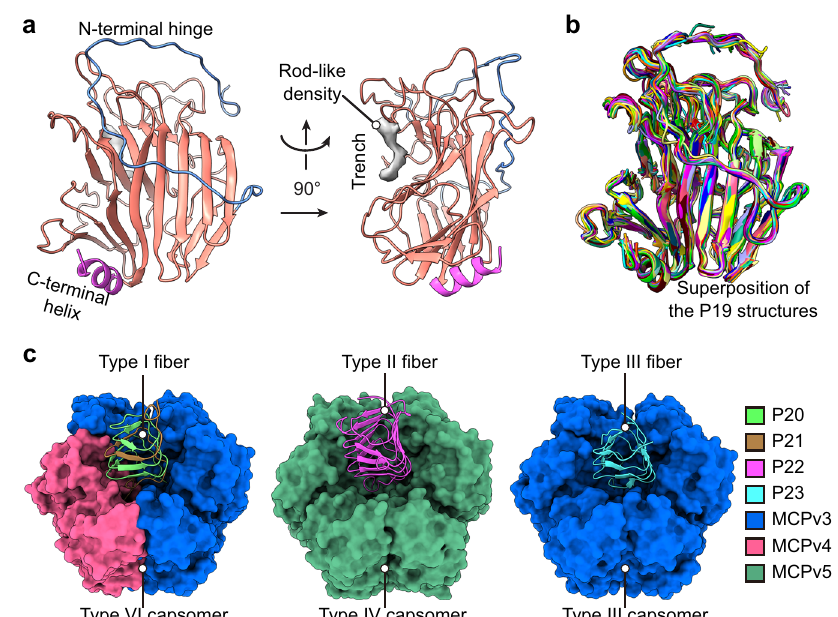
Fig.6|Structuresofthe fi ngerproteinsand fi bers.a Ribbondiagramofonecopy of the fi nger protein, P19, with the rod-like cryo-EM density in its trench. b Superpositionofthe25copiesoftheP19proteinswithinone fi vefoldasymmetric